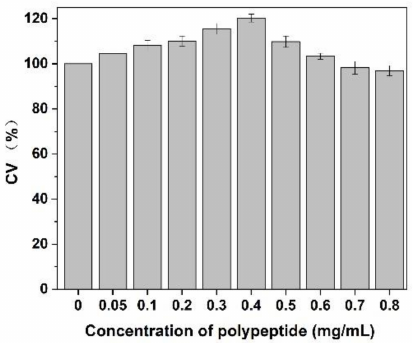
Figure 9. The effect of different concentrations of Cornus officinalis peptides on CEF cell proliferation. Experimental conditions: phosphate buffer (pH 7.4), at 37 ◦ C.